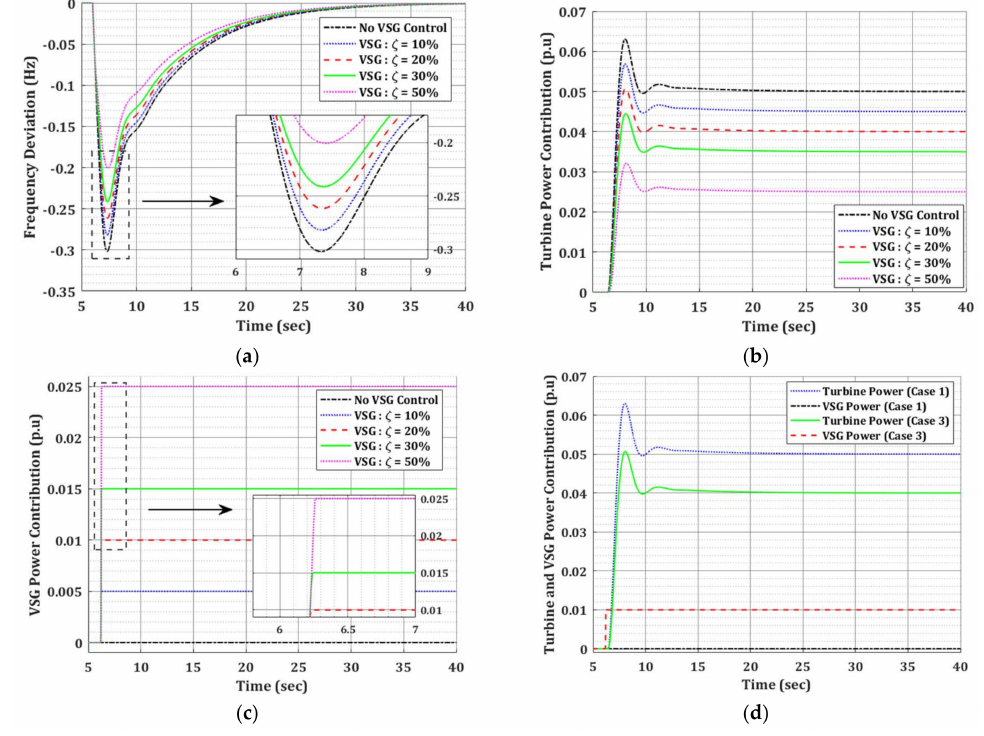
Figure 7. Effect of VSG control share ( ζ ) on various system parameters under load disturbance: ( a ) system frequency response; ( b ) change in turbine power (p.u); ( c ) change in VSG power (p.u); and ( d ) change in turbine and VSG power (p.u) for selected